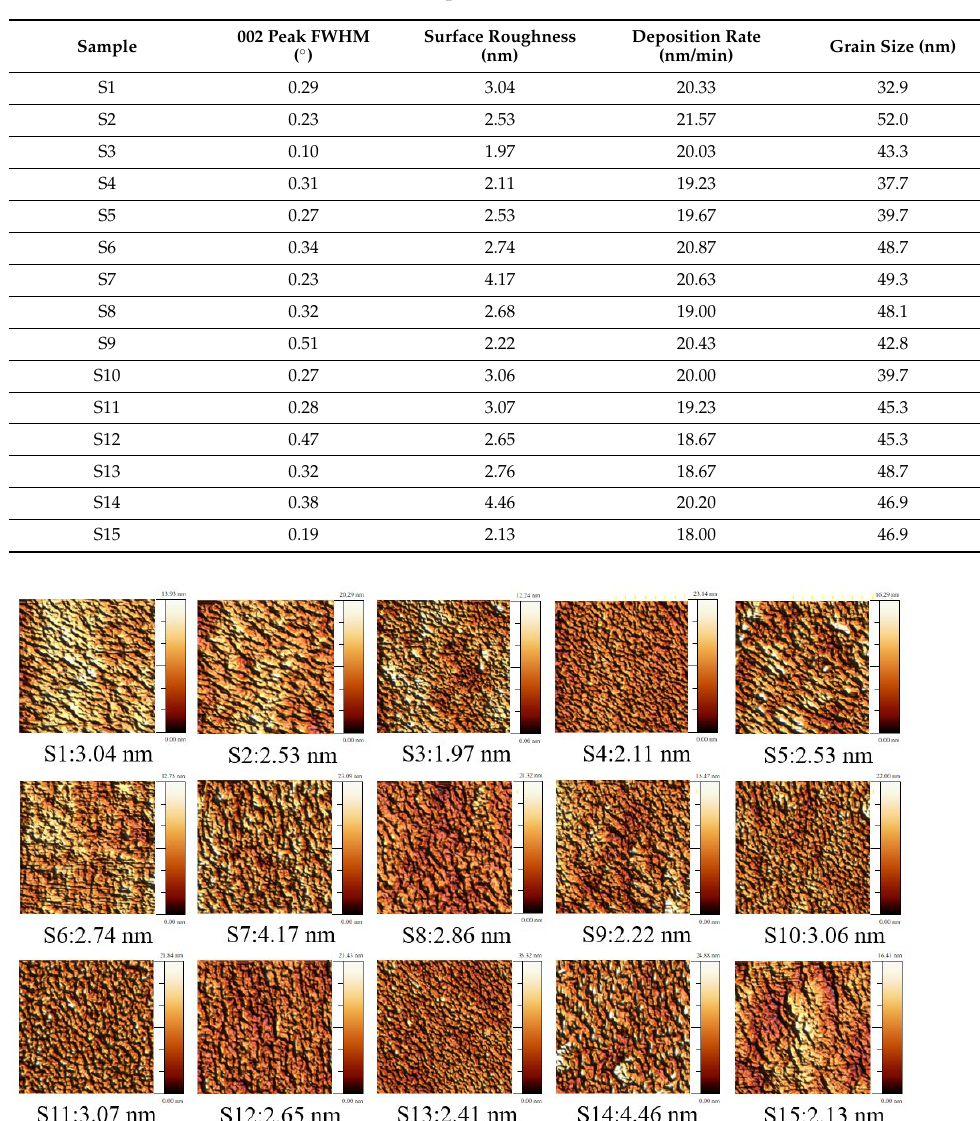
Figure 7. The surface roughness with root-mean-square (RMS) after process completion for the